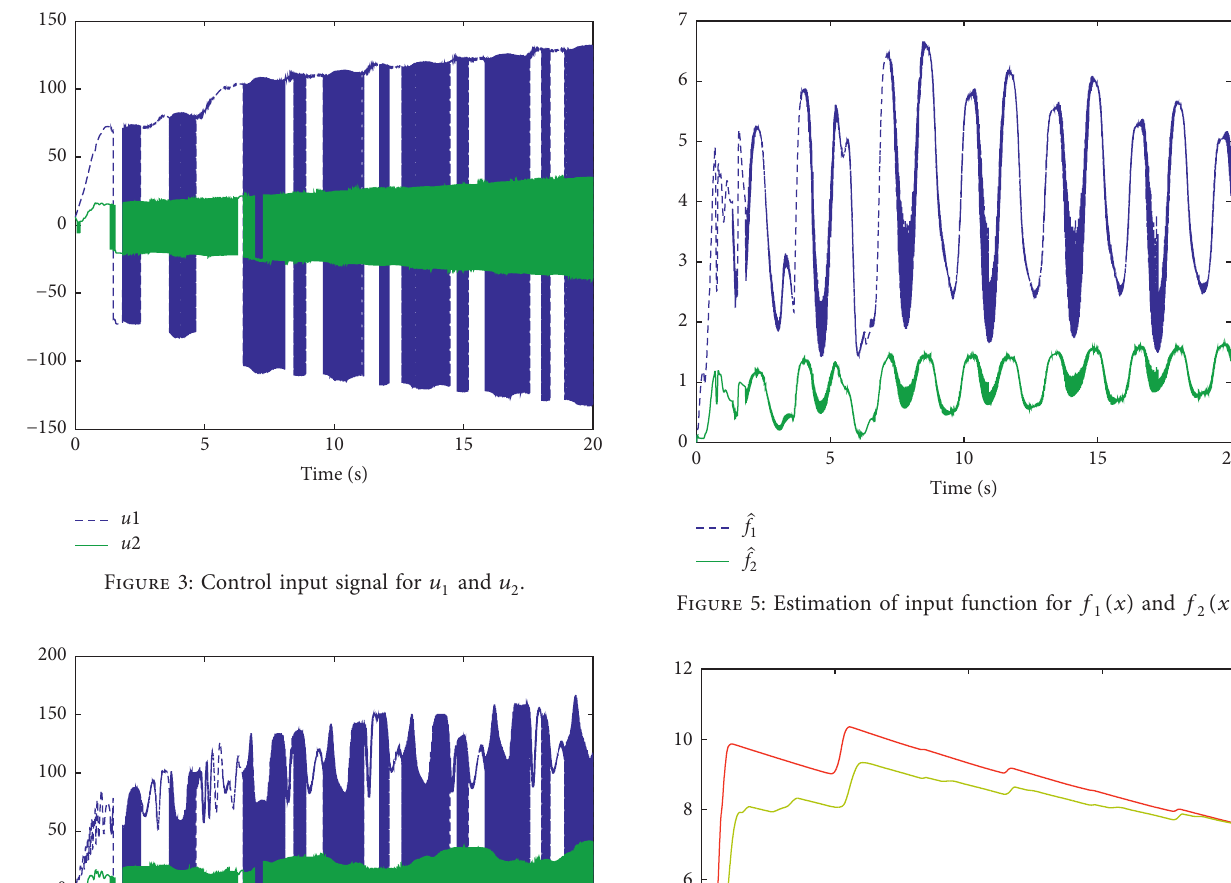
Figure 5: Estimation of input function for f